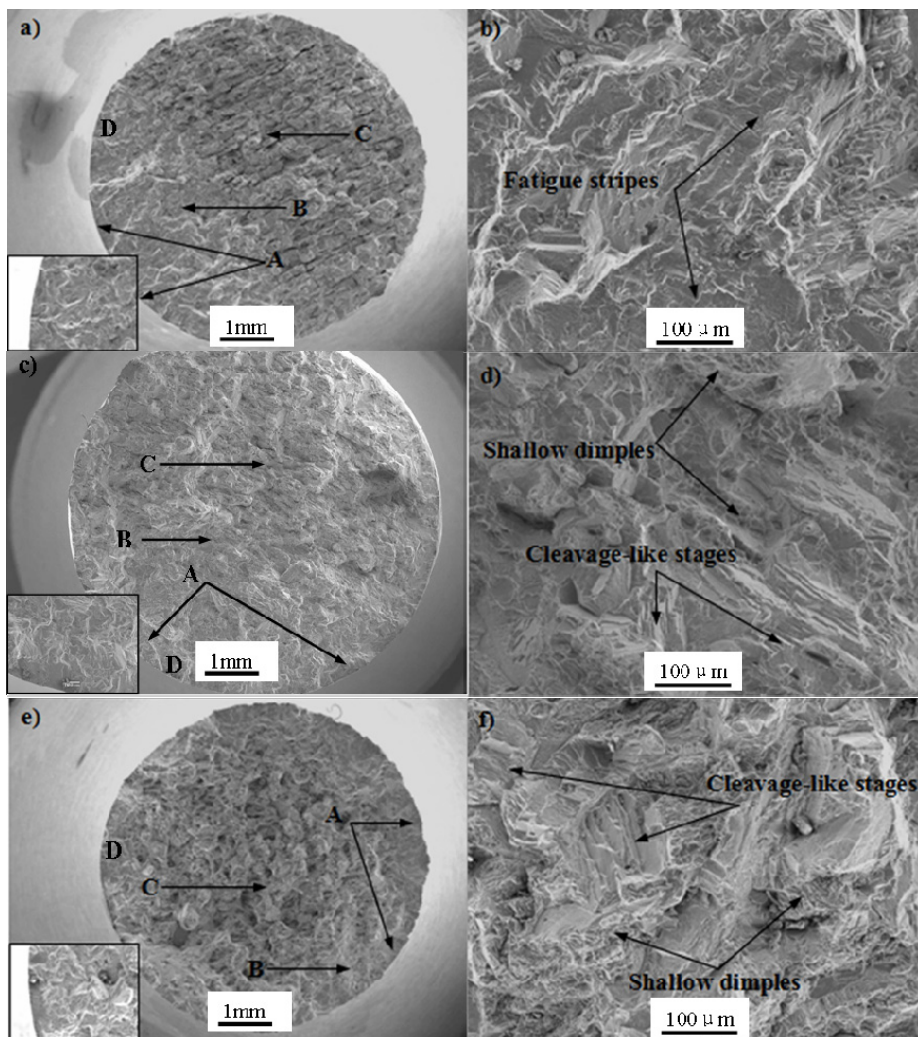
Figure 8. Fractographs of Pro.II after LCF at 650 °C. ( a , b ) Δε t /2 = 0.4%; ( c , d ) Δε t /2 = 0.6%; ( e , f ) Δε t /2 = 0.8%.